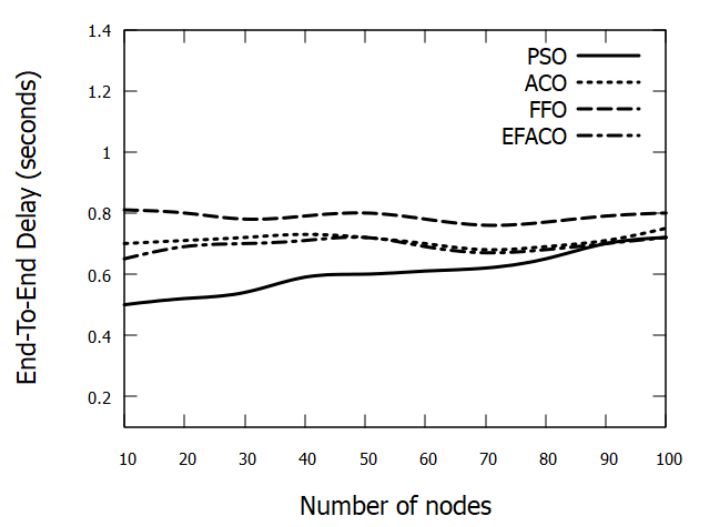
Figure 7. Comparison between proposed PSO, ACO, FFO, EFACO for End-to-End Delay with a number of nodes.